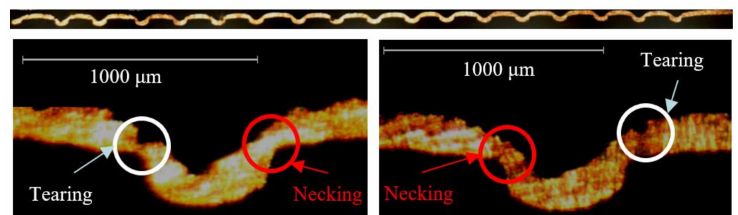
Figure 7. The cross section of the deformed Cu110 sheet at a capacitor bank energy of 6.4 kJ.